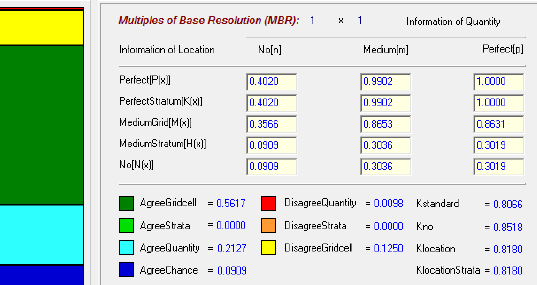
Figure 3. Agreement between classified LULC and predicted LULC map in